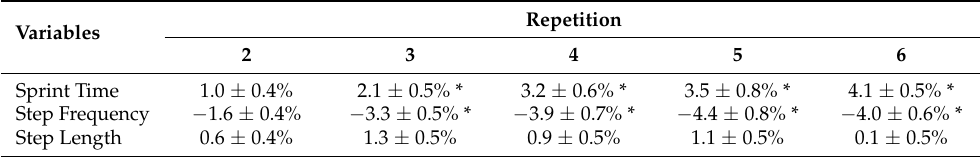
Figure 2. Evolution of step kinematics during RSA in elite female field hockey players. (*) Different from the first repetition at p < 0.05; (#) different from the last repetition at p < 0.05. Table 1. Percentage changes in relation to the first repetition of the stride kinematics during RSA in elite female field hockey players. (*) Different from the first repetition at p < 0.05.